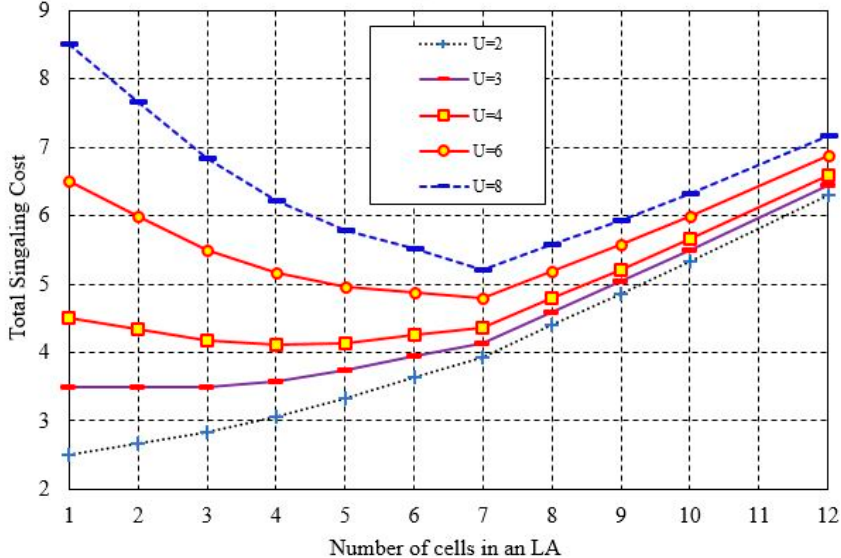
Figure 11. Total signaling cost for various Us (CMR = 1/3).